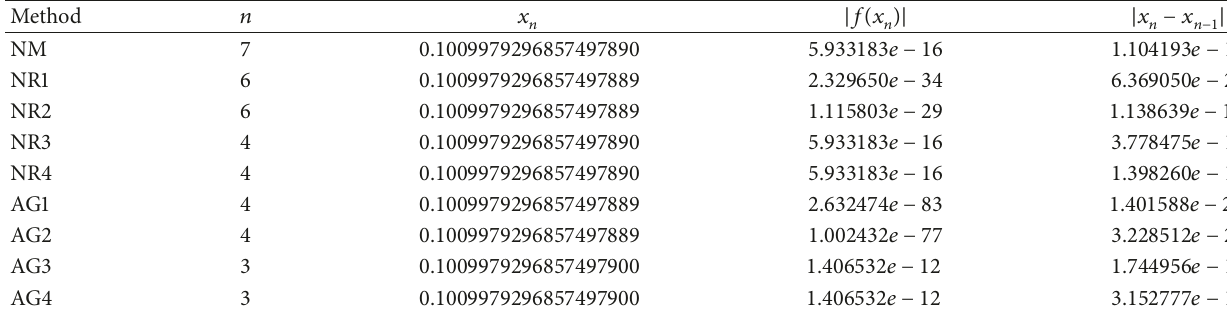
Table 1: Numerical results for population model (equation (72))